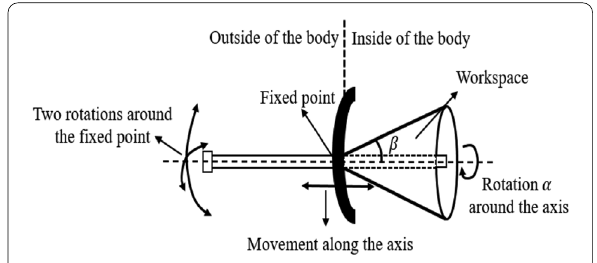
Figure 1 DOFs and workspace of the end